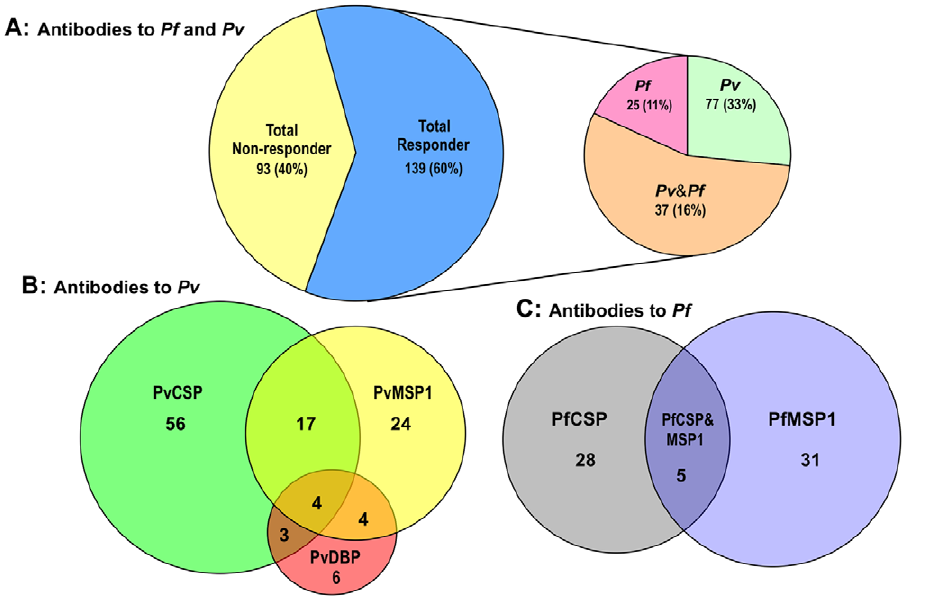
Figure 1. Broad antibody responses against malaria were induced by natural exposures in Colombia. We assessed malaria antigen- specific antibody responses in 233 donors living in Caribbean coast town (Apartado and Turbo) of Colombia. One hundred thirty nine (60%) donors had antibodies against at least one of five malaria antigens examined. Numbers represent the responders who had antibodies against both P. vivax and/or P. falciparum antigens (A), different P. vivax antigens, PvCSP, PvMSP1, PvDBP (B), or different P. falciparum antigens PfCSP and PfMSP1 (C).